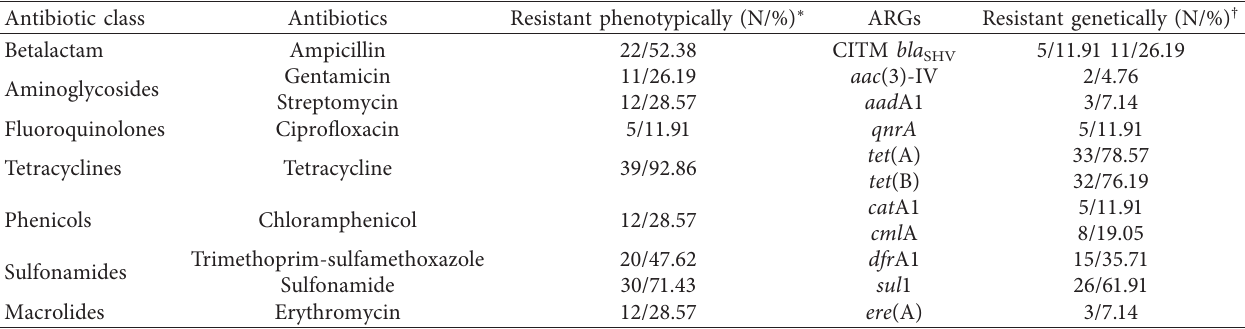
Table 3: Phenotypic antimicrobial resistance and the presence of antimicrobial resistance genes in uropathogenic E. coli isolates ( n � 42). Antibiotic class